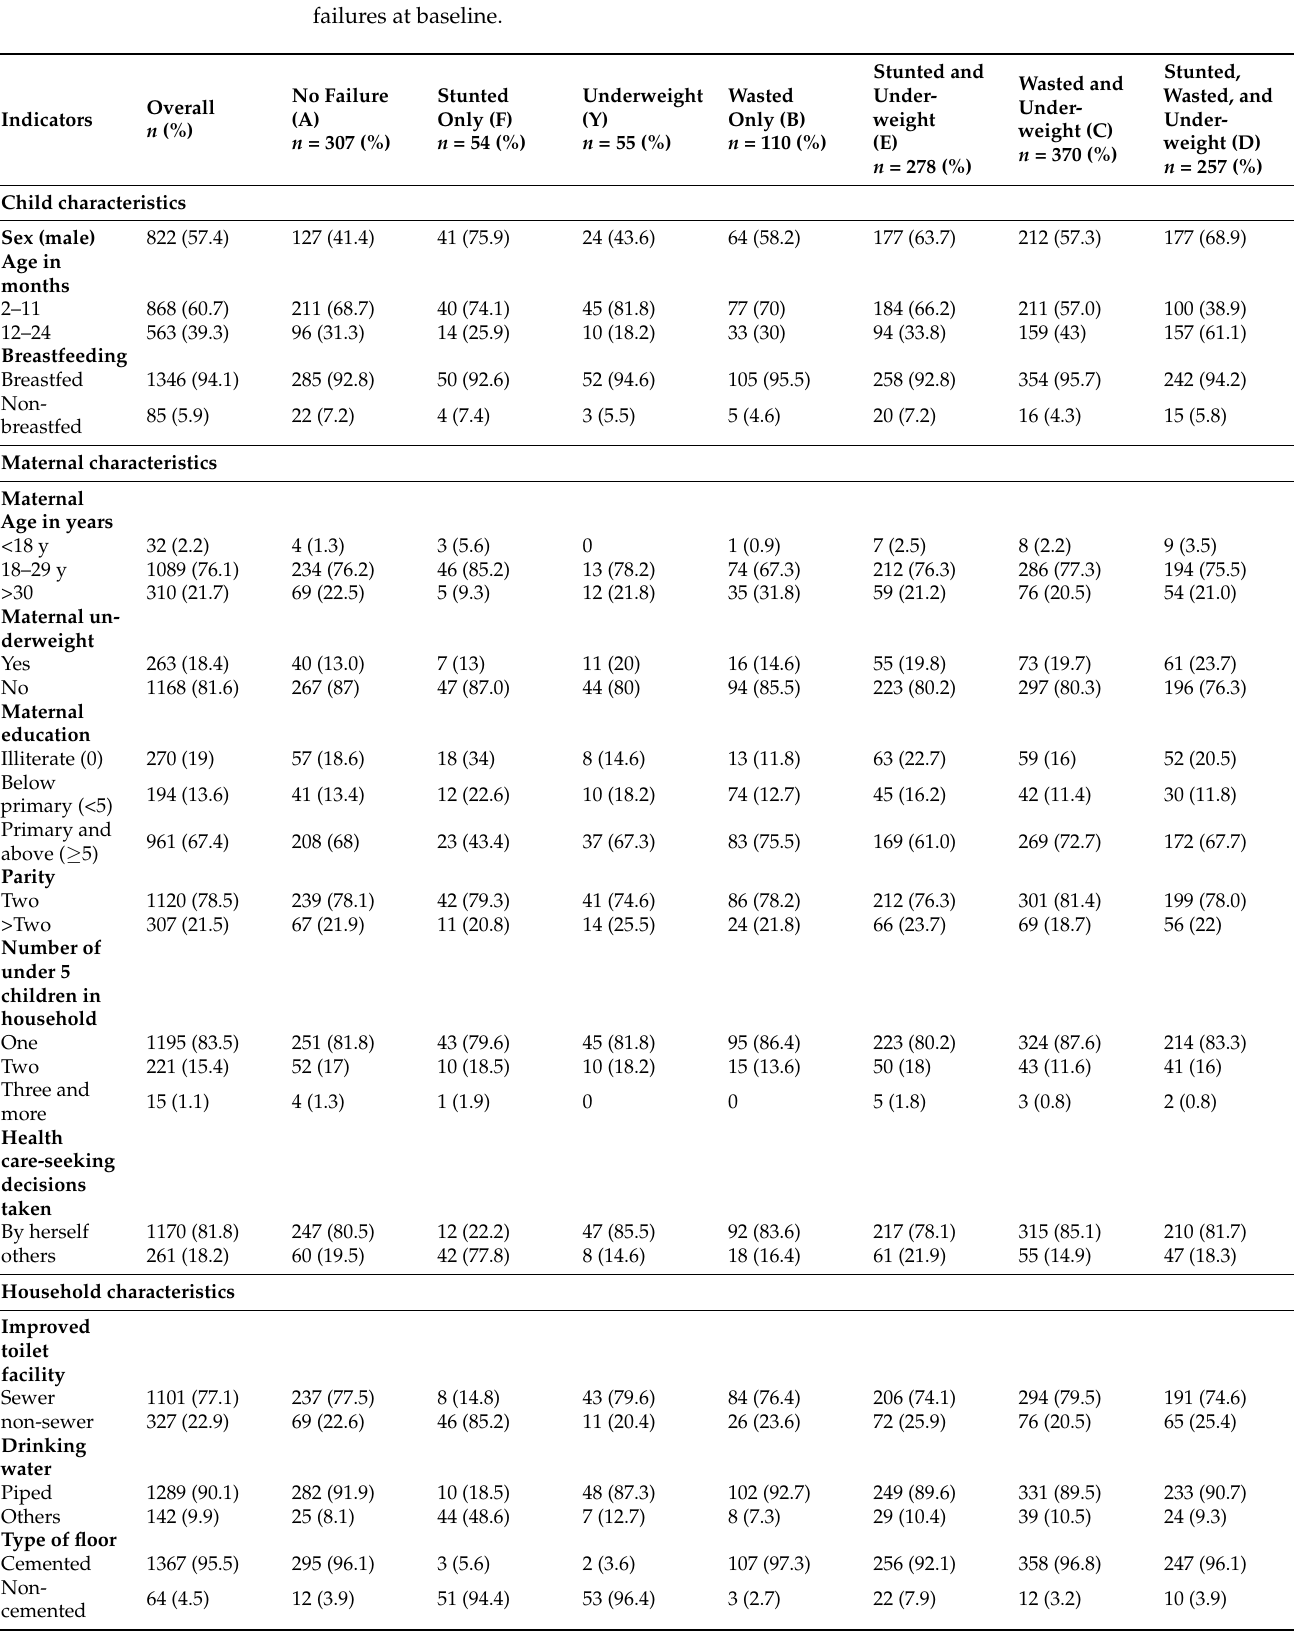
Table 3. Distribution of maternal, child, and household characteristics by the 7 anthropometric failures at